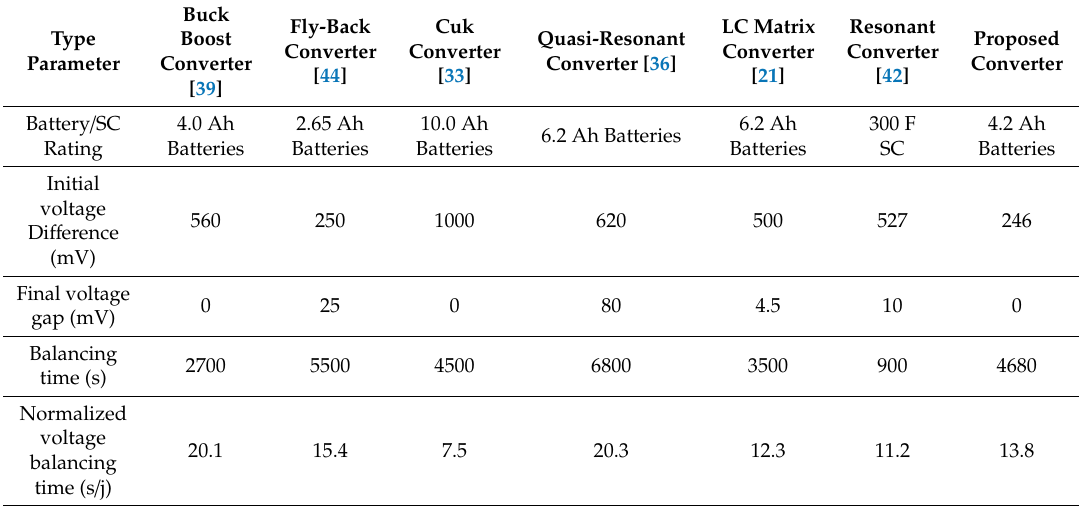
Table 3. Balancing performance comparison between conventional and the proposed